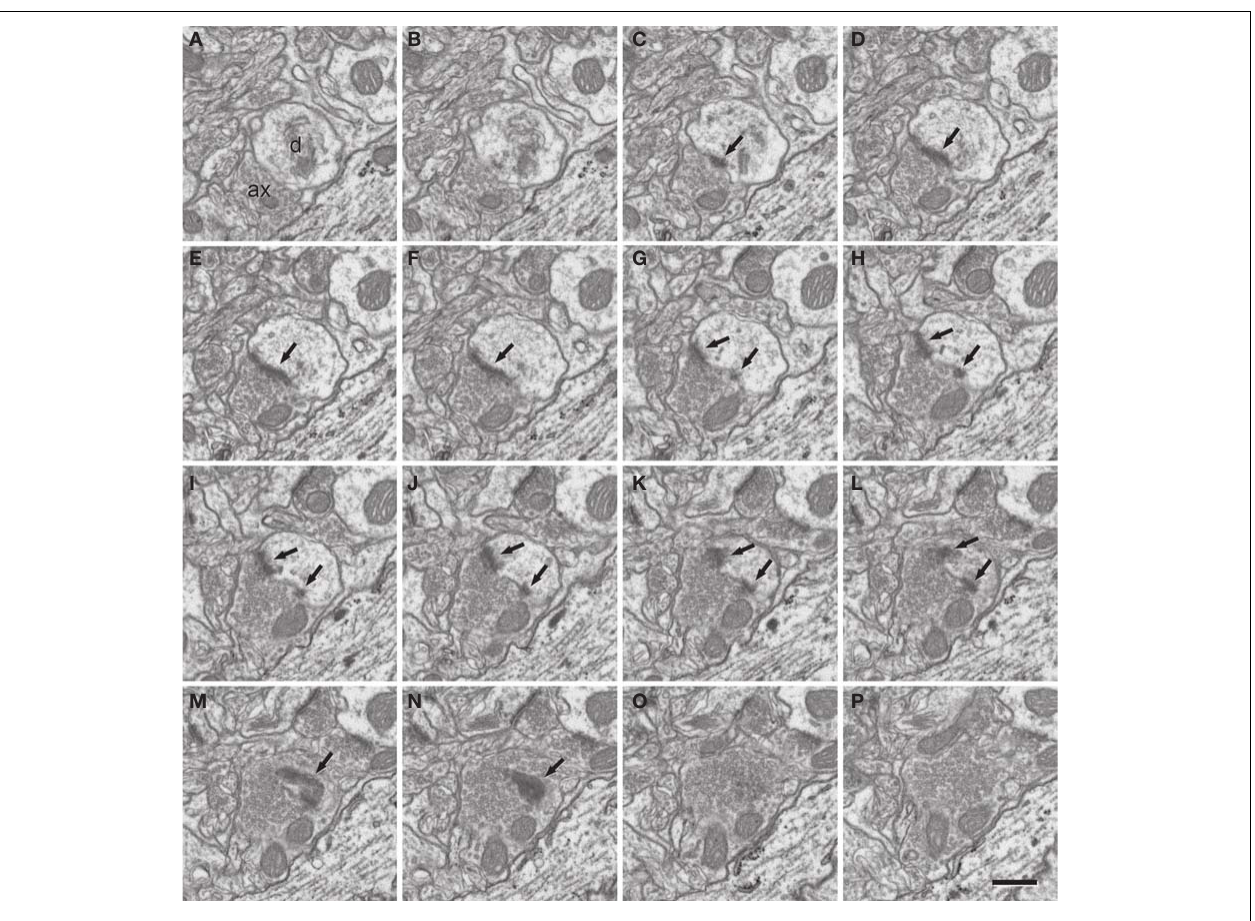
evident in sections (C) to (N) . Due to the fact that the synaptic junction is ring-shaped, there are two densities in sections (G) to (L) . The examination of serial sections greatly facilitates the correct interpretation of this synapse as a perforated asymmetric synapse. For example, if only single sections were used, the sections in which the synaptic junction has been cut en face [ (M) and (N) ] would have been diffi cult to interpret. A three dimensional reconstruction of this synapse is represented in Figure 6 . Section thickness, 19.9 nm. Scale bar, 500 nm.